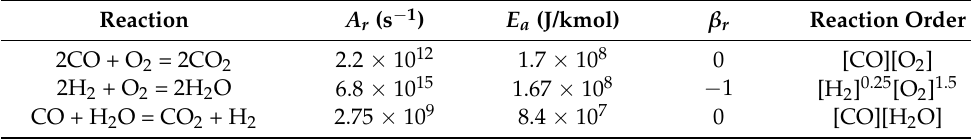
Table 2. Kinetic parameters of homogenous reactions